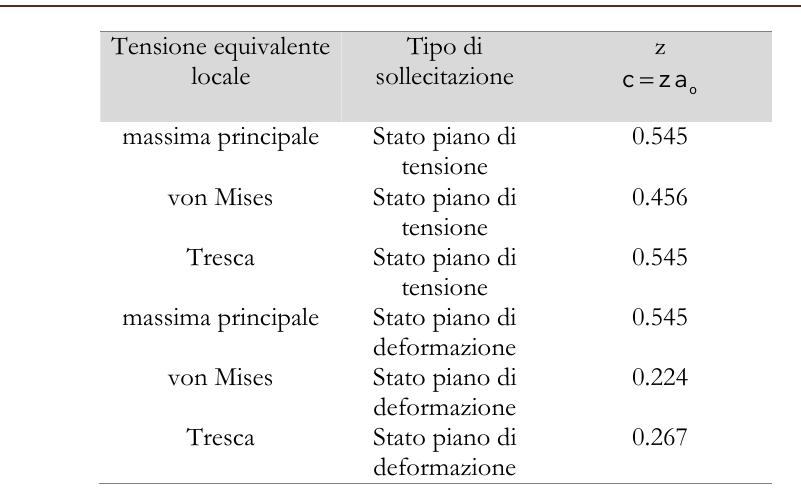
Tabella 1: Valori del parametro z per differenti tensioni equivalenti [12].